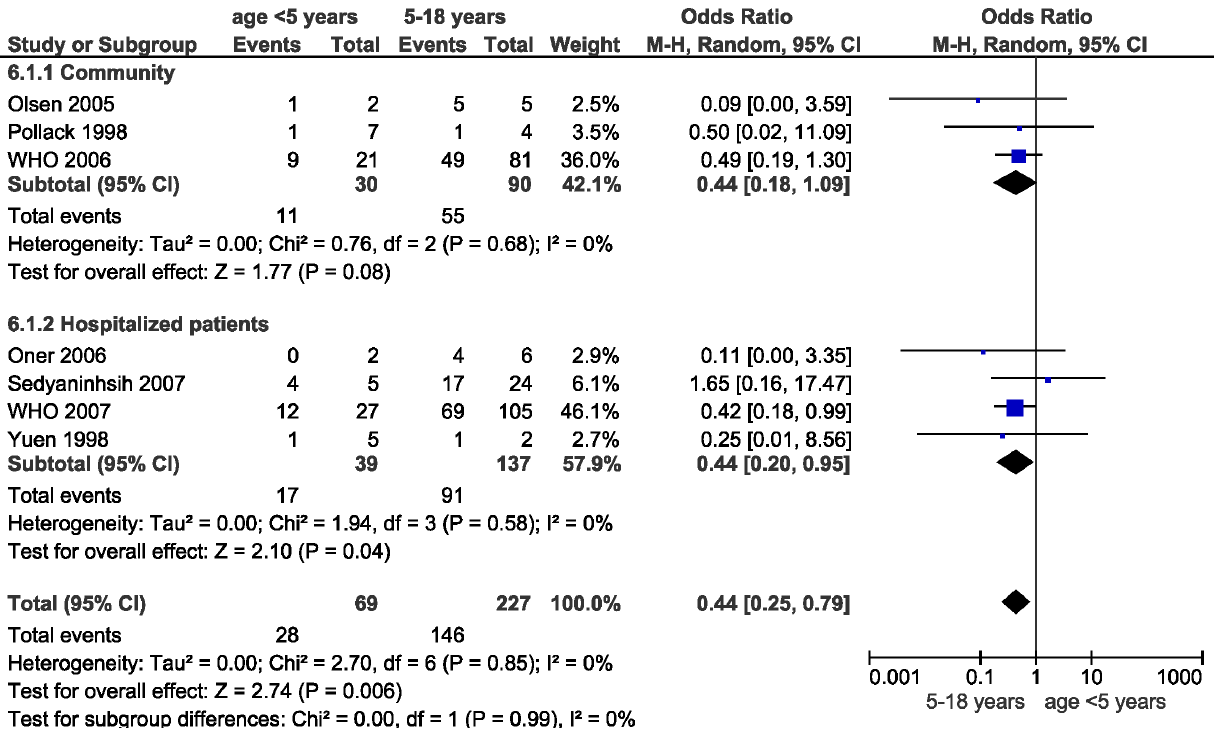
Figure 3. Forest plot comparing mortality in children less than 5 years of age to 5–18 years of age. doi:10.1371/journal.pone.0089697.g003 H5N1 avian influenza (Figure 1). All studies were cohort studies